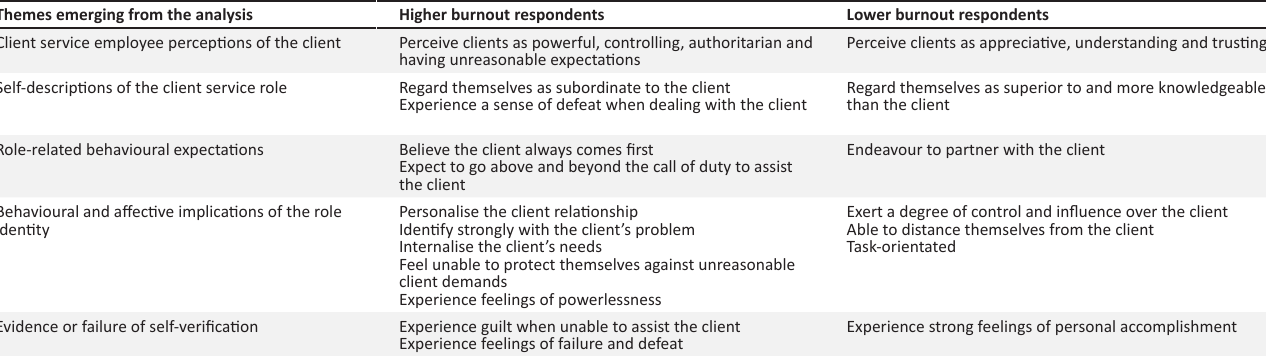
TABLE 1: Main themes emerging from the data. Themes emerging from the analysis Higher burnout